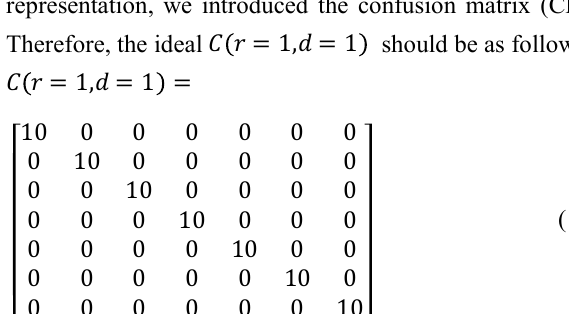
where, is the confusion matrix, and is the number of folds. The above matrix is the  representation of 1 group of ideal confusion matrices in 1  iteration. Thus, the